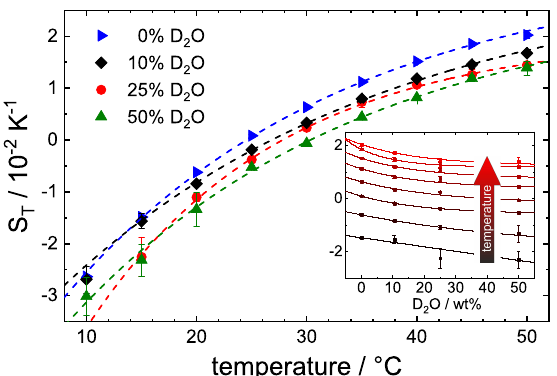
Figure 6. Soret coefficient S T against temperature for STV (39 mg/mL) in buffer solutions with varying percentages of D 2 O. The inset shows S T against the percentages of D 2 O for different